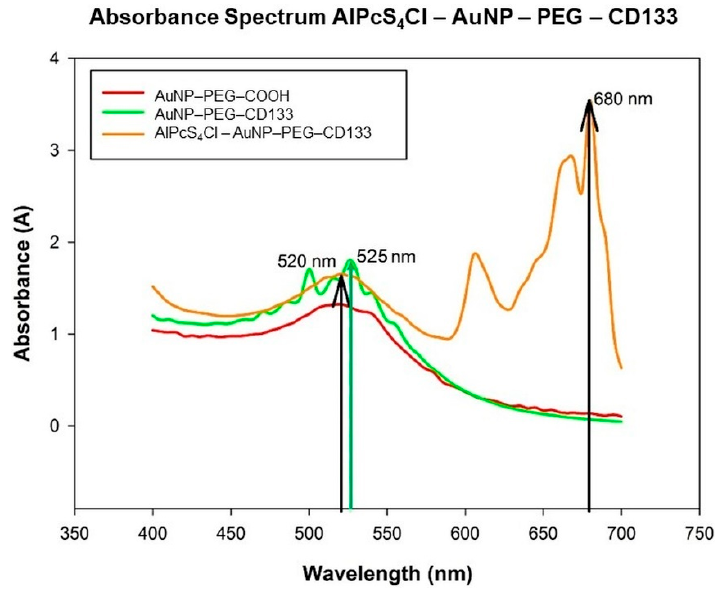
Figure 5. Absorbance spectrum of AuNP-PEG-COOH (red), AuNP-PEG-CD133 indicating a slight resonance peak shift at 525 nm due to the coupling of the Ab to the AuNP (green) and AlPcS 4 Cl-AuNP-PEG-CD133, with the particles respective absorbance peaks at 520 and 680 nm (orange).